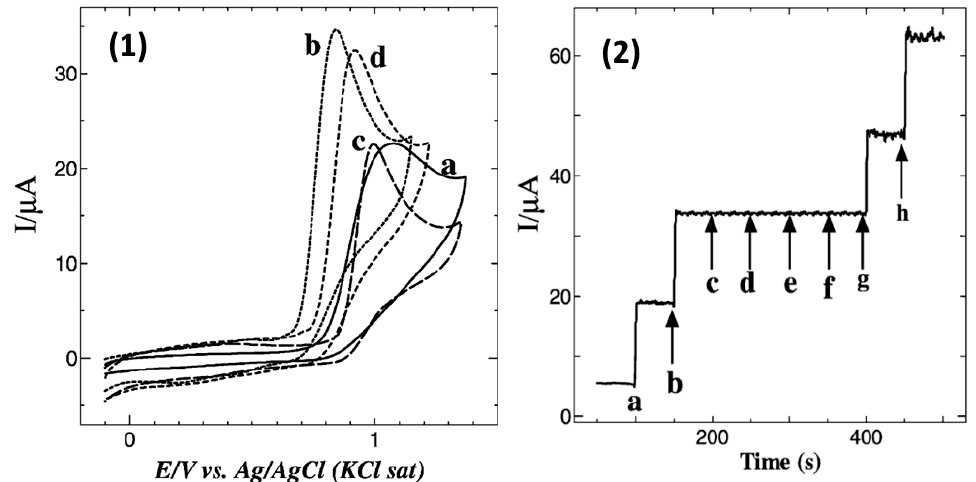
Figure 4. ( 1 ) CVs obtained for 0.5 mM NO at (a) bare GC electrode, (b) 4 α -Co II TAPc, (c) 4 α -H 2 TAPc and (d) 4 α -Co II TAPc modified GC electrodes in 0.2 M PB solution (pH 2.5) at a scan rate of 0.05 V/s. ( 2 ) Amperometric I(T) curve for the addition of 10 µ M of NO (a and b) and 1 mM each of glucose (c), urea (d), oxalate (e) and NaCl (f) and final additions of 10 µ M of NO (g,h) at 4 α -Co II TAPc SAM modified GC electrode in 0.2 M PBS (pH 2.5). Reprinted with permission from Ref. [56]. Copyright 2010 John Wiley and Sons.